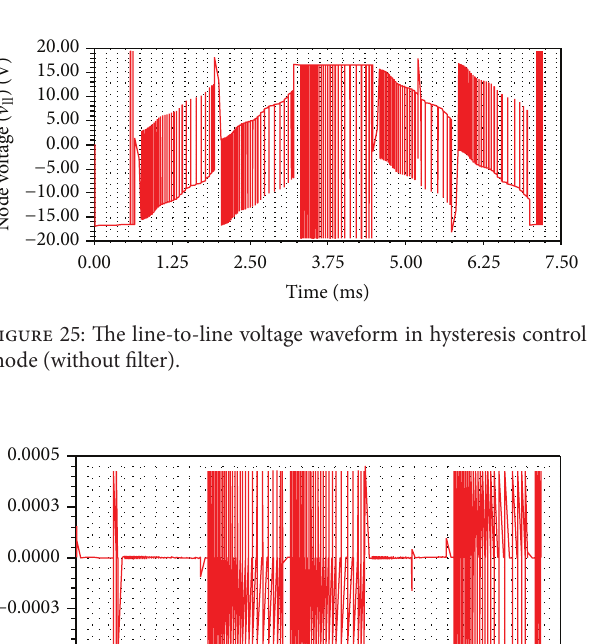
Figure 22: The leakage current (with LCL filter, capacitor bank, and RLD snubber).